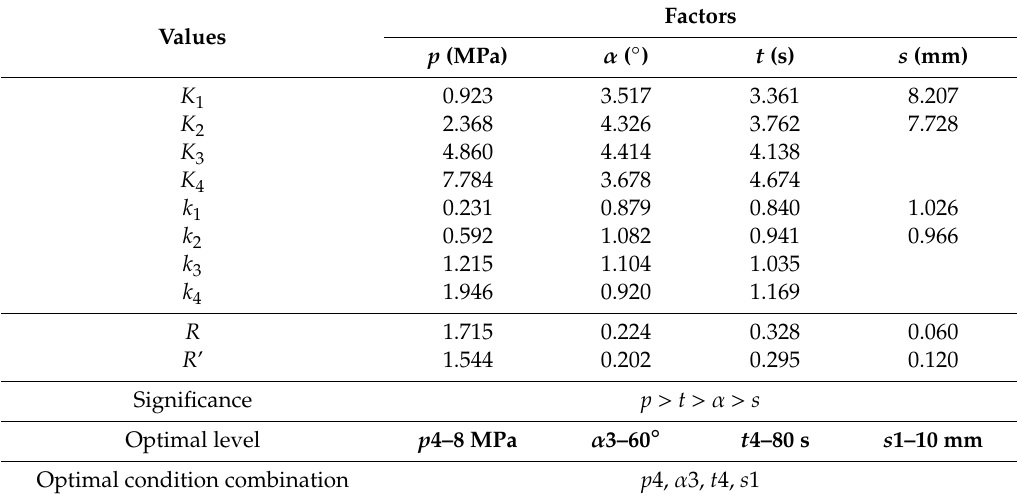
Table 3. Range analysis table of the erosion depth. (Optimal condition combination indices refer to the rows of the table).